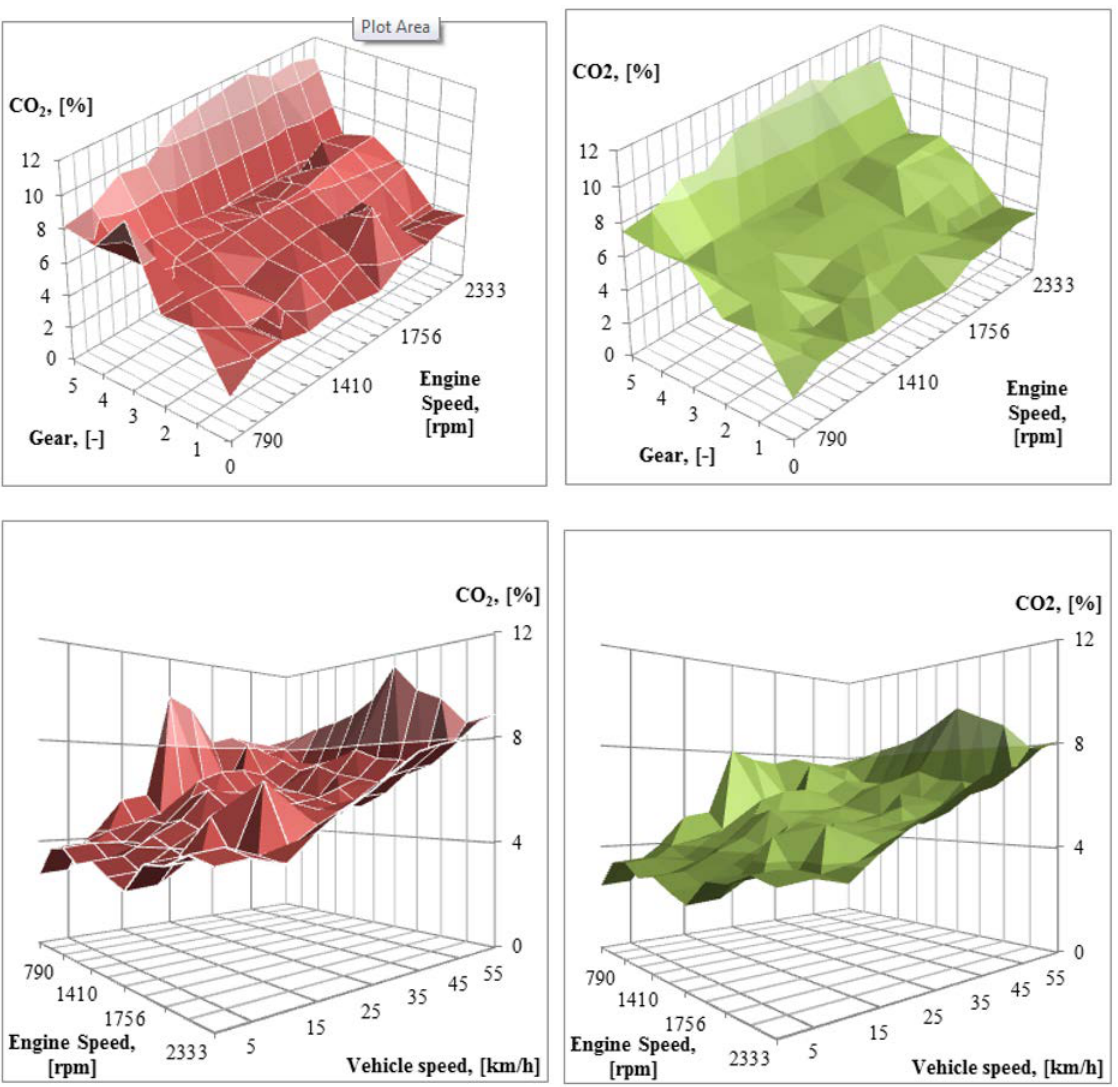
Figure 14. Carbon dioxide emissions versus engine speed for different gear ratios. a. CO 2 versus engine speed for different gear ratios in standard operating conditions; b. CO 2 versus engine speed for different gear ratios with IAP operation; c. CO 2 versus engine speed for different vehicle speeds in standard operation; d. CO 2 versus engine speed for different vehicle speeds with IAP